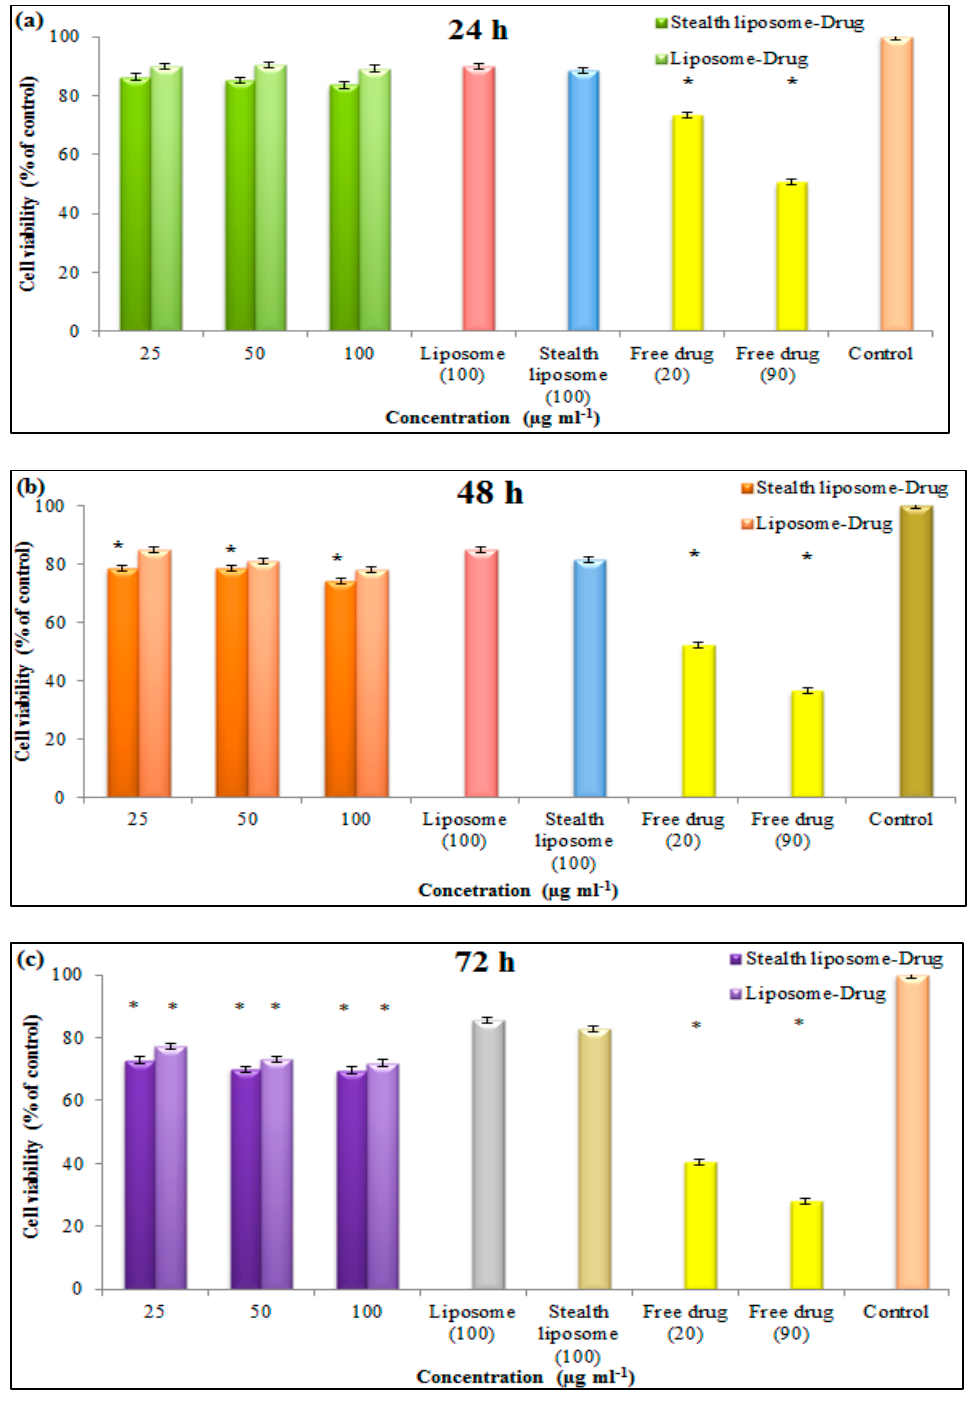
Figure 8. Results of MTT assay of liposome and stealth liposome after ( a ) 24 h, ( b ) 48 h, and ( c ) 72 h on the MCF7 cell line (* p ≤ 0.05).